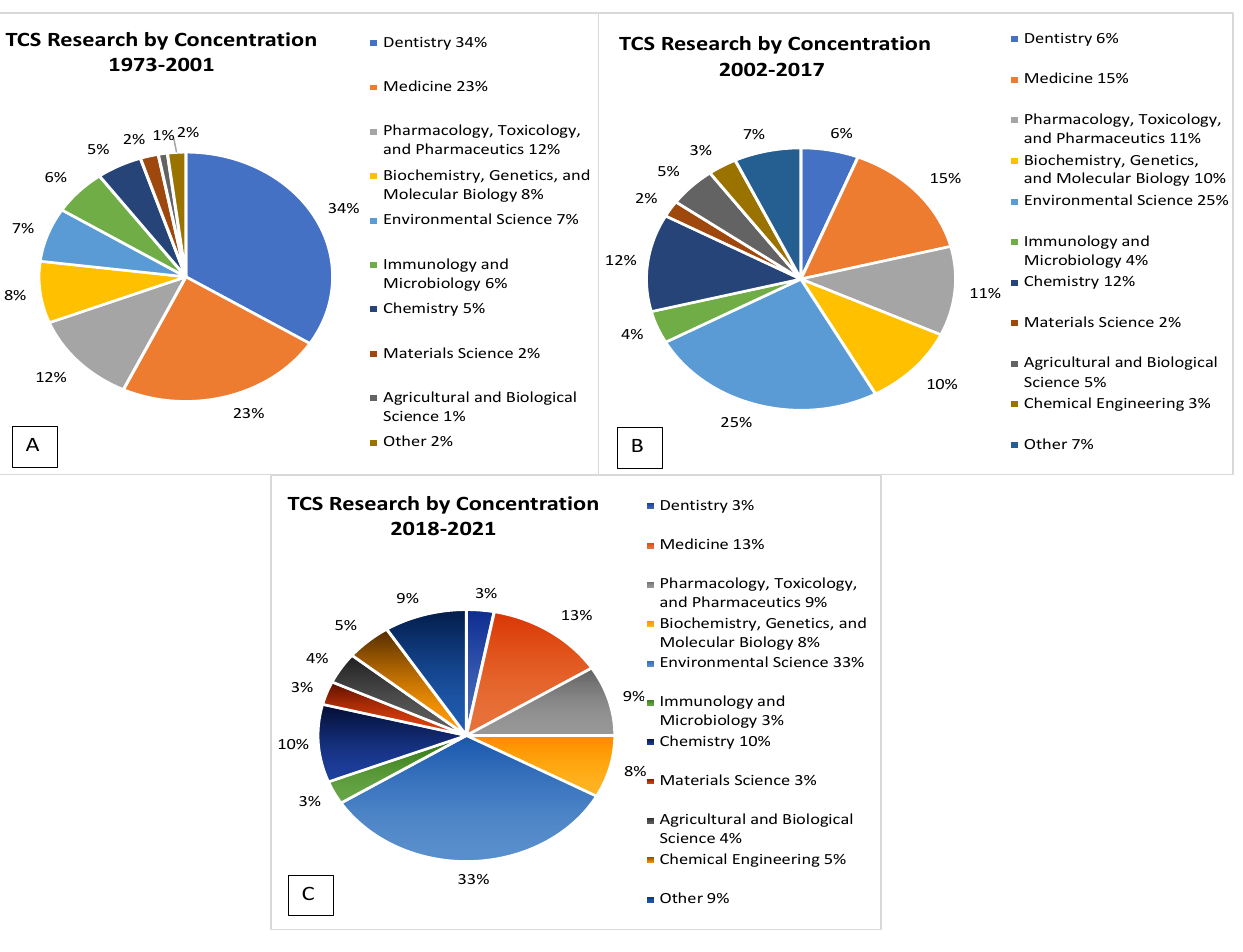
Figure 3. Concentrations of TCS ‐ related research over three phases. Phase 1: 1973–2001. Phase 2: 2002–2017. Phase 3: 2018–2021. Values outside of the chart indicate the number of publications in each concentration. Percentages of these values can be found in the legend.